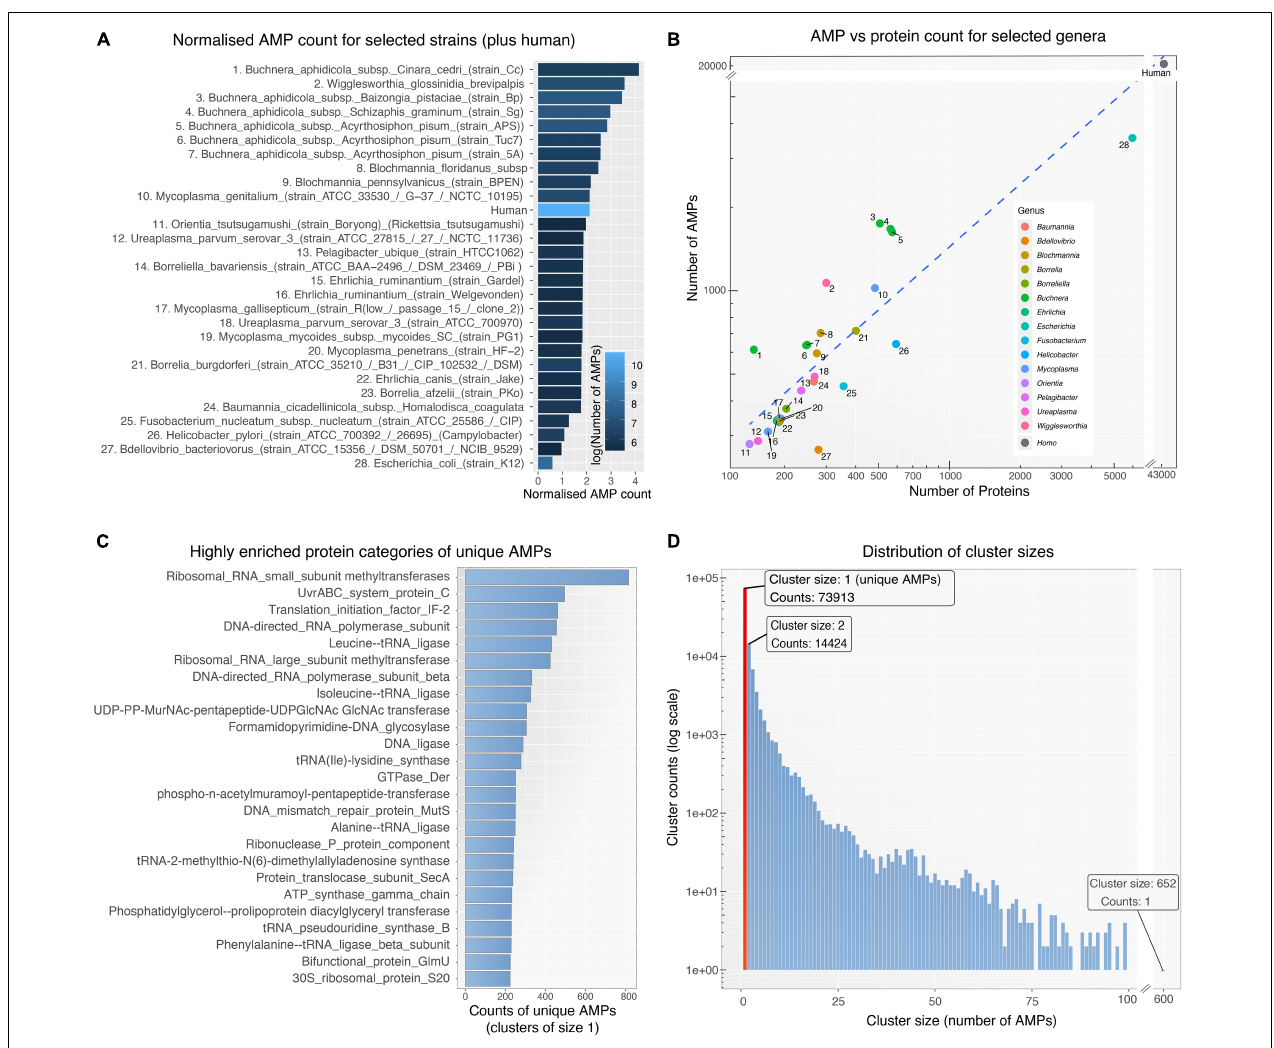
FIGURE 1 | (A) Normalized AMP counts for bacterial species with the highest number of predicted AMPs (1–25), selected species of interest (26–28) and human. AMP counts were normalized by the number of proteins included in the prediction process (AMP/protein ratio). Due to filtering of proteins (only curated Swiss-Prot taken in consideration) some species had very few remaining proteins. For visualization purposes, only species with at least 140 remaining proteins are shown above. The color scale represents the actual number of AMPs for each organism. (B) Scatter plot showing the number of predicted AMPs against the number of proteins used as input to AMPA software for each organism. Numerical labels correspond to the species in 1a while color groups represent taxa. (C) The 25 most enriched protein categories derived from clusters of size 1 (i.e., unique AMPs). (D) Histogram for all 109.678 clusters showing the distribution of clusters size (i.e., number of AMPs within the cluster – AMPs with > 80% sequence similarity). The red bar highlights the large number of unique AMPs (cluster size of 1).